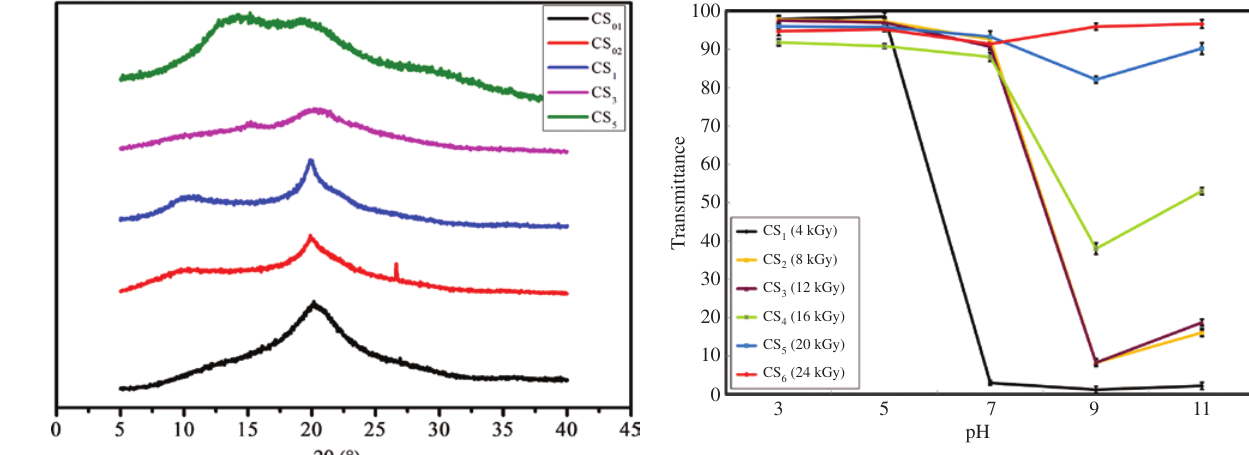
, chitosan soaked in H 01 = 15.85 kDa), CS (M 1 w